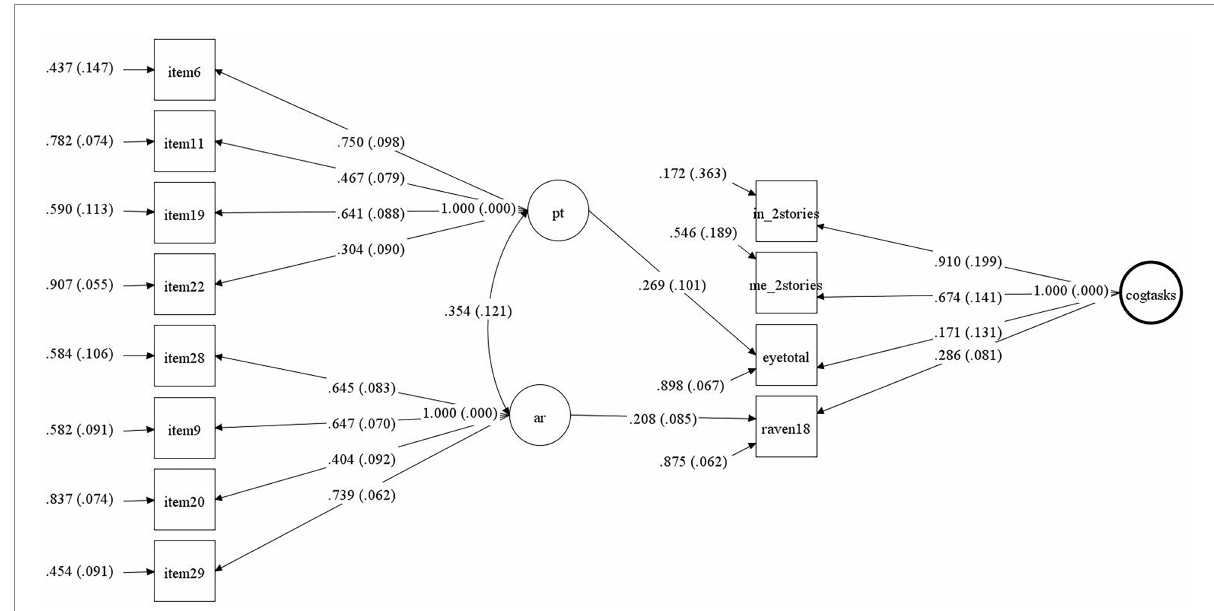
FIGURE 1 Latent variable model representing tested relations between self-reported an task measures. pt. = perspective-taking; ar = affective response; cogtasks = cognitive tasks; eyetotal = Eyes test; Raven 18 = Ravens fluid test; in_2stories = IMT intentions; and me_2stories = IMT